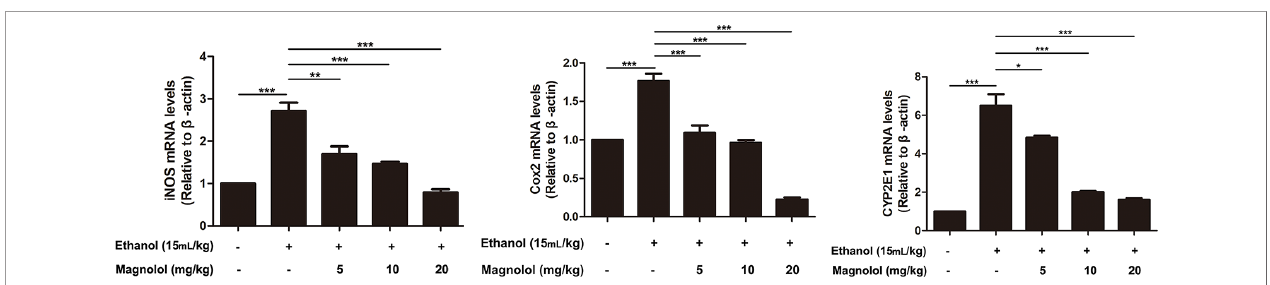
FIGURE 4 | Effects of magnolol on mice alcohol-induced liver damage in iNOS, Cox-2, and CYP2E1 at the genetic level. q-RT PCR analysis was used to detect the expression of iNOS, Cox2, and CYP2E1 at the genetic level. The data is presented as mean ± SD. (*P < 0.05, **P < 0.01, ***P < 0.001).